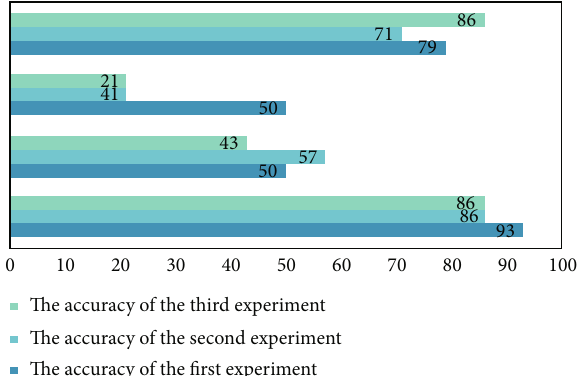
Figure 3: Identi fi cation process accuracy (%) for the nonstationary K -means training set.